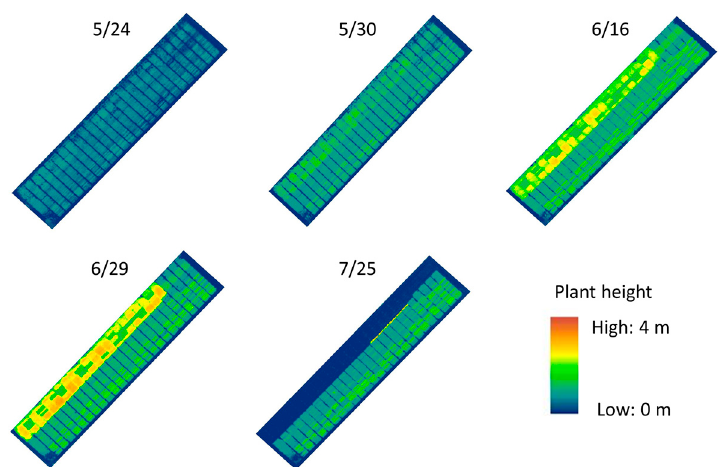
Figure 12. Height comparison datasets with the digital surface model on 05/24, 05/30, 06/16, 6/29, and 07/25 in the sorghum field.